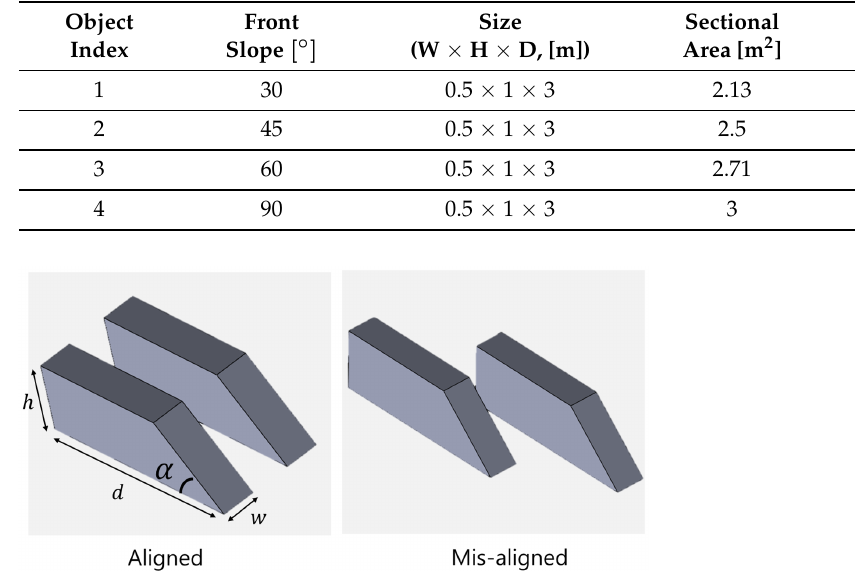
Figure 8. Two different deployments of objects: aligned and misaligned.